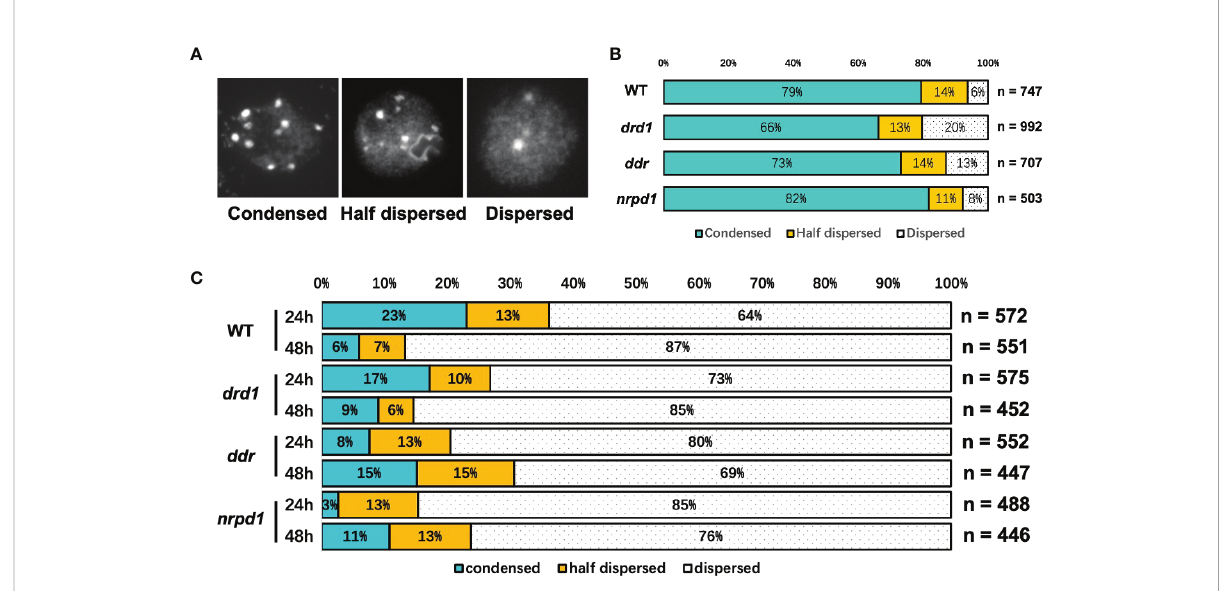
FIGURE 4 Heterochromatic condensation levels in DDR complex-associated mutants as per nuclear staining analysis. (A) Representative images of three heterochromatin states in the DAPI-stained nucleus include: condensed, half dispersed, and dispersed. (B) The bars show the percentage of the nuclei in the three states (A) in wild type and drd1 , ddr , and nrpd1 mutants as a percentage of the total count under no-stress (NS) condition. (C) Percentage of nuclei in the three states after 24 and 48 h of HS. (n is the total number of analyzed